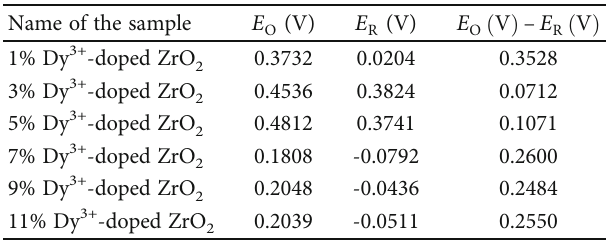
E Table 5: EIS data of Dy 3+ -doped ZrO R ), the